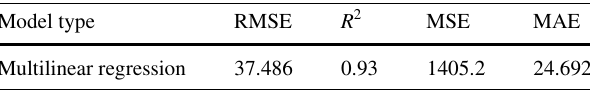
Fig. 6 Residuals of the tested GP models Table 3 Summary of the results of the multilinear regression model selection